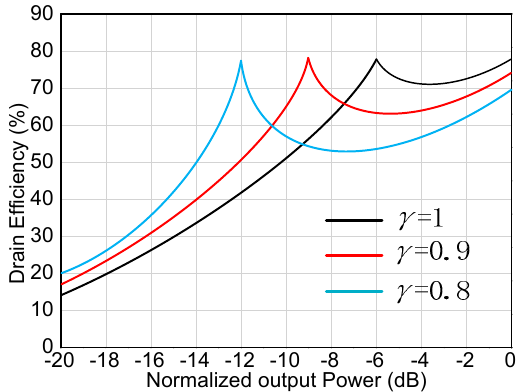
Figure 4. Drain efficiency versus normalized output power. Figure 4. Drain e ffi ciency versus normalized output